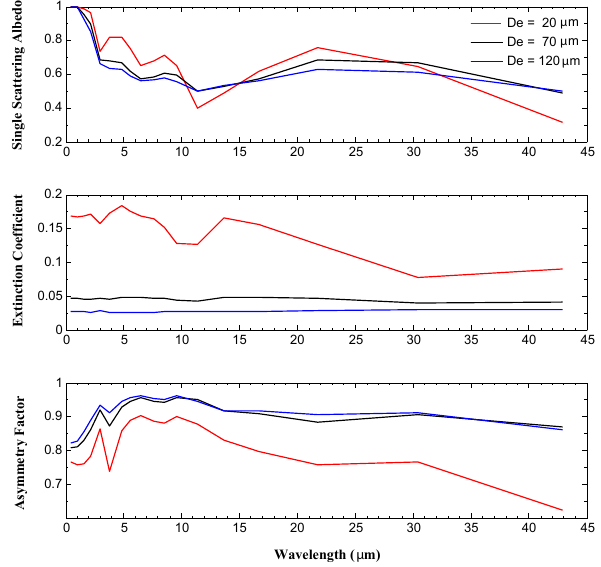
Fig. 3. Single scattering albedo (top panel), extinction coefficient Fig. 3 (middle panel), and asymmetry factor (bottom panel) as a function of wavelength for different ice crystal mean effective sizes calcu- lated based on mixed